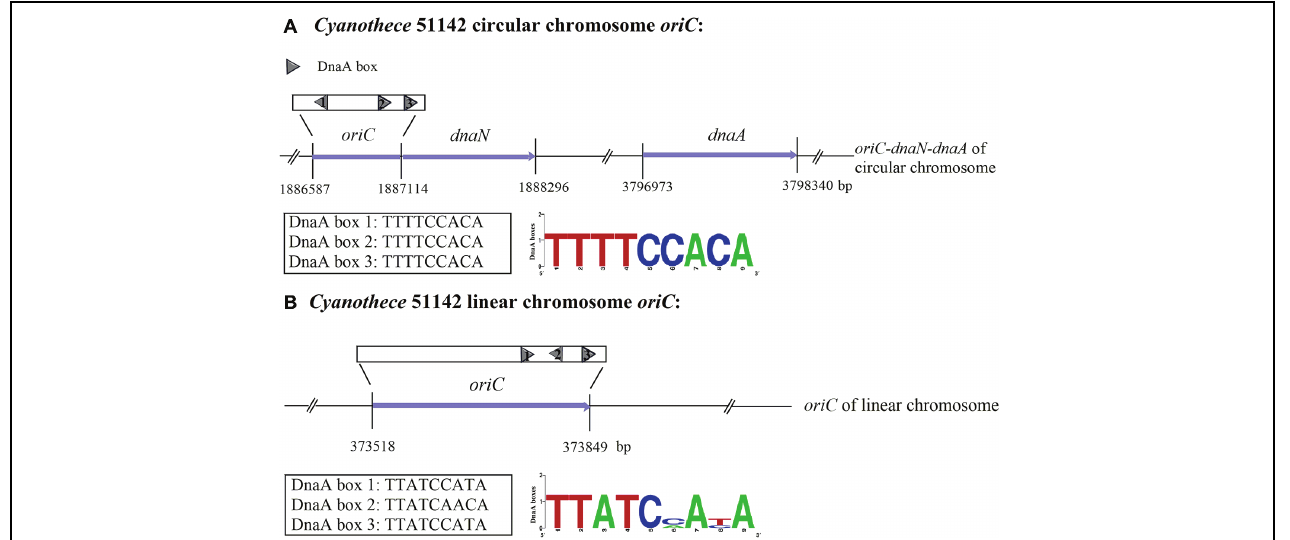
FIGURE 1 | The sequences and structure of the Cyanothece 51142 oriC regions (not to scale). The predicted DnaA boxes 1–3 of the circular and linear chromosomes and their orientation are represented by gray pentagons. The DnaA box sequence for the circular chromosome is all TTTTCCACA, as shown in the DnaA boxes logo. The sequences of the two DnaA boxes from the linear chromosome are TTATCCATA and the other one is TTATCAACA. (A) The oriC of the circular chromosome of Cyanothece 51142 was predicted to be next to the start of the dnaN gene, and the dnaA gene is located downstream of the origin of the circular chromosome. The sequence of DnaA boxes is TTTTCCACA. (B) The oriC of the linear chromosome has been found in the region from 373518 to 373849 nt. The three DnaA boxes of both circular and linear chromosomes have been tagged.